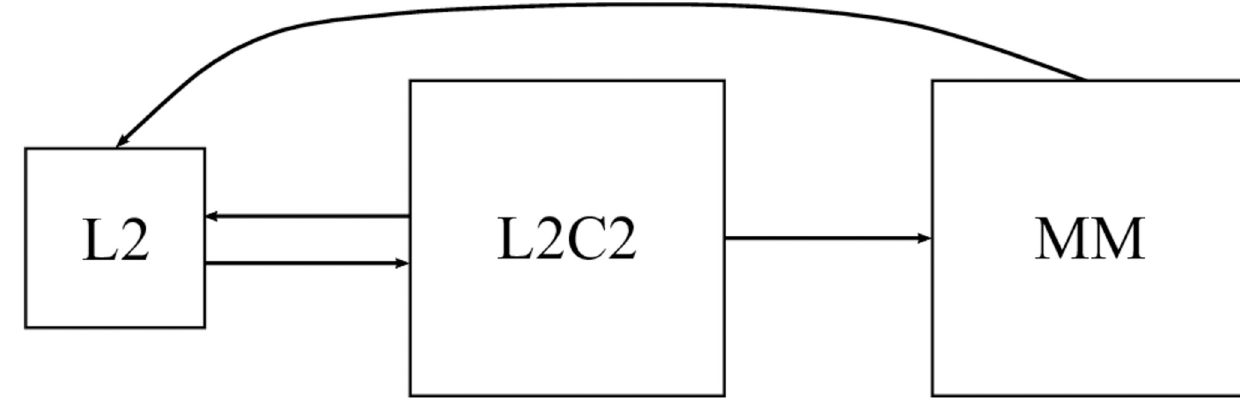
Fig 2. Block flow diagram of non-inclusive